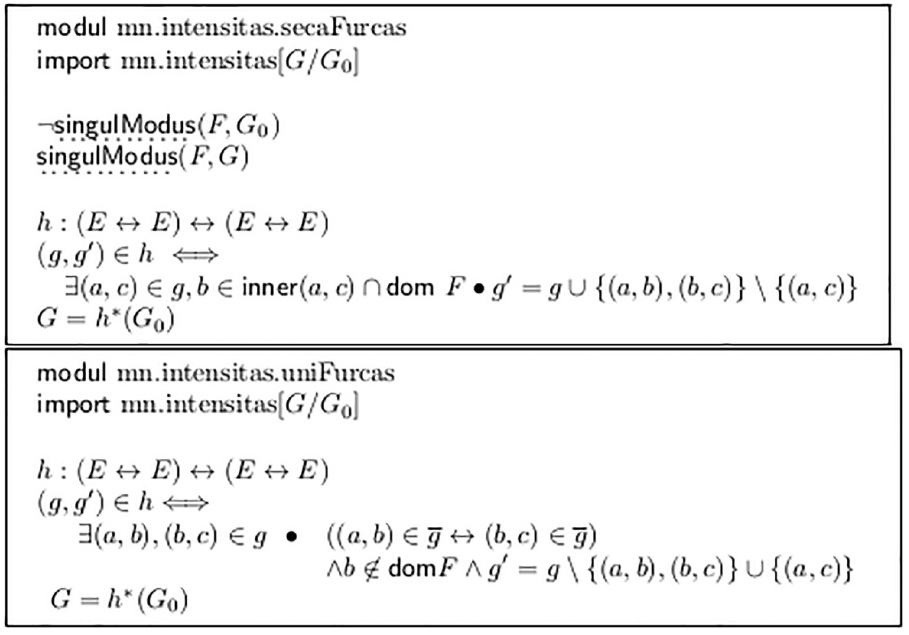
Fig 12. Transformations of